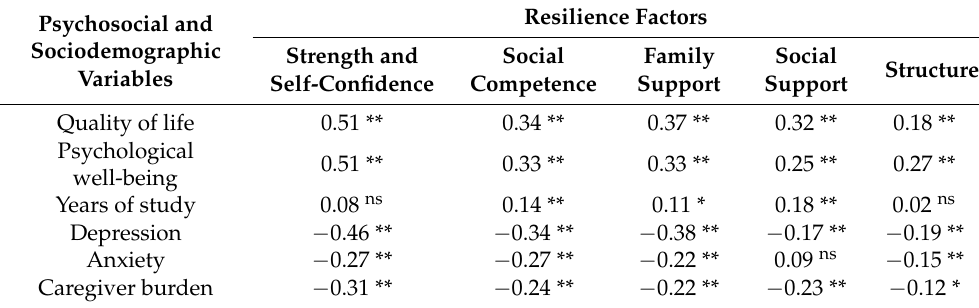
Table 3. Correlations with resilience